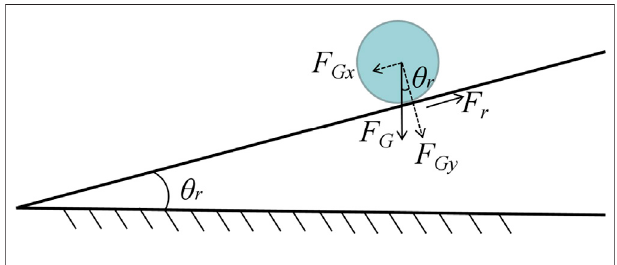
FIGURE 3 | Balance of force in rolling friction